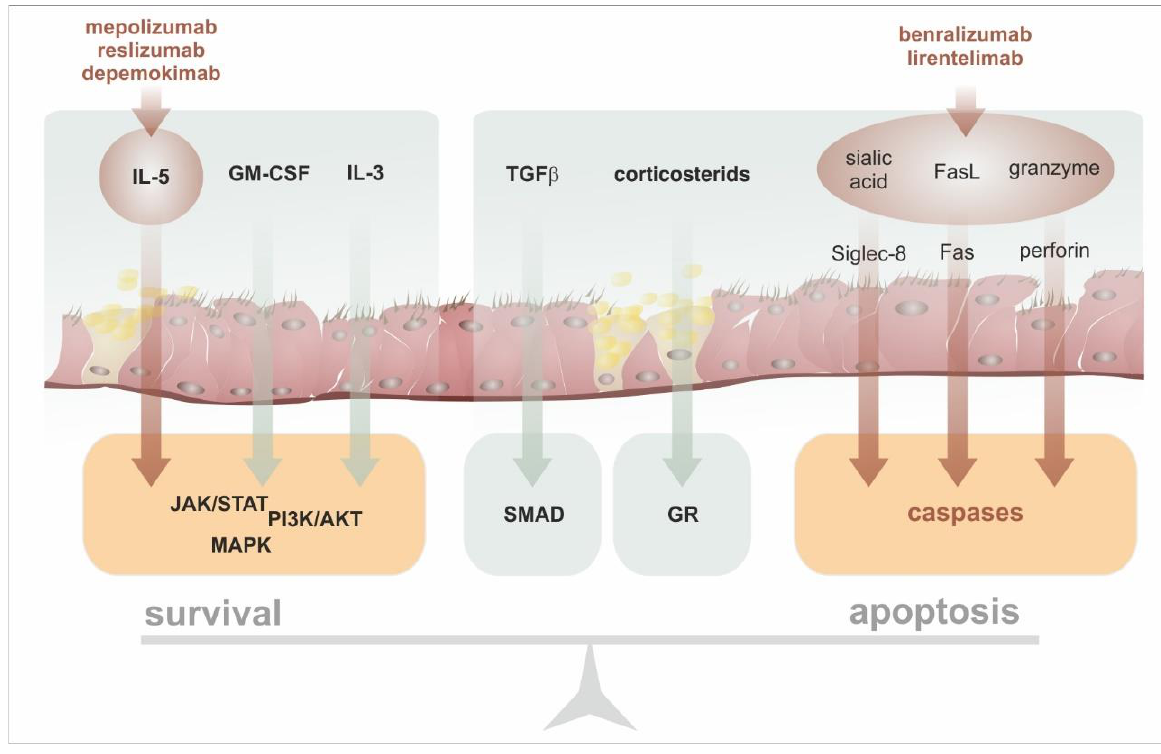
Figure 8. Mode of action of antieosinophil biologicals. Eosinophil survival is always a result of the balance between prosurvival and proapoptotic signals. In general, mepolizumab, reslizumab, and depemokimab are biologicals with an anti-IL-5 mode of action that lead to a reduction in the lifespan of eosinophils. In contrast, benralizumab can induce the apoptosis of targeted eosinophils by utilizing ADCC through ligation of the Fas receptor and the activation of caspases in response to an intracellular influx of granzyme. Lirentelimab can signal through the inhibitory Siglec-8 receptor. Abbreviations: Fas/FasL (CD95/CD95L) — subgroup of the tumour necrosis factor receptor family that contains an intracellular ‘death domain’ and can trigger apoptosis, GR — glucocorticosteroid receptor, TGFβ—transforming growth factor β, SMAD/JAK/STAT/PI3K/MAPK—intracellular kinases.